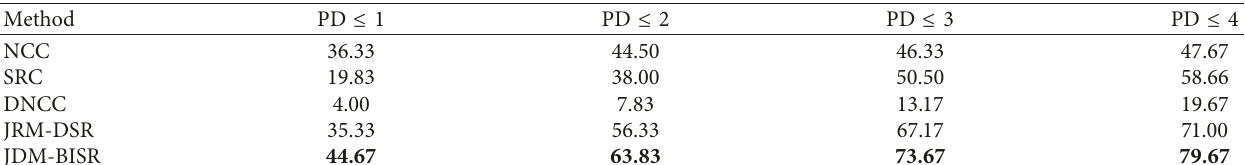
Table 4: The matching accuracy of different methods, where the standard deviation of Gaussian blur kernel is 4.